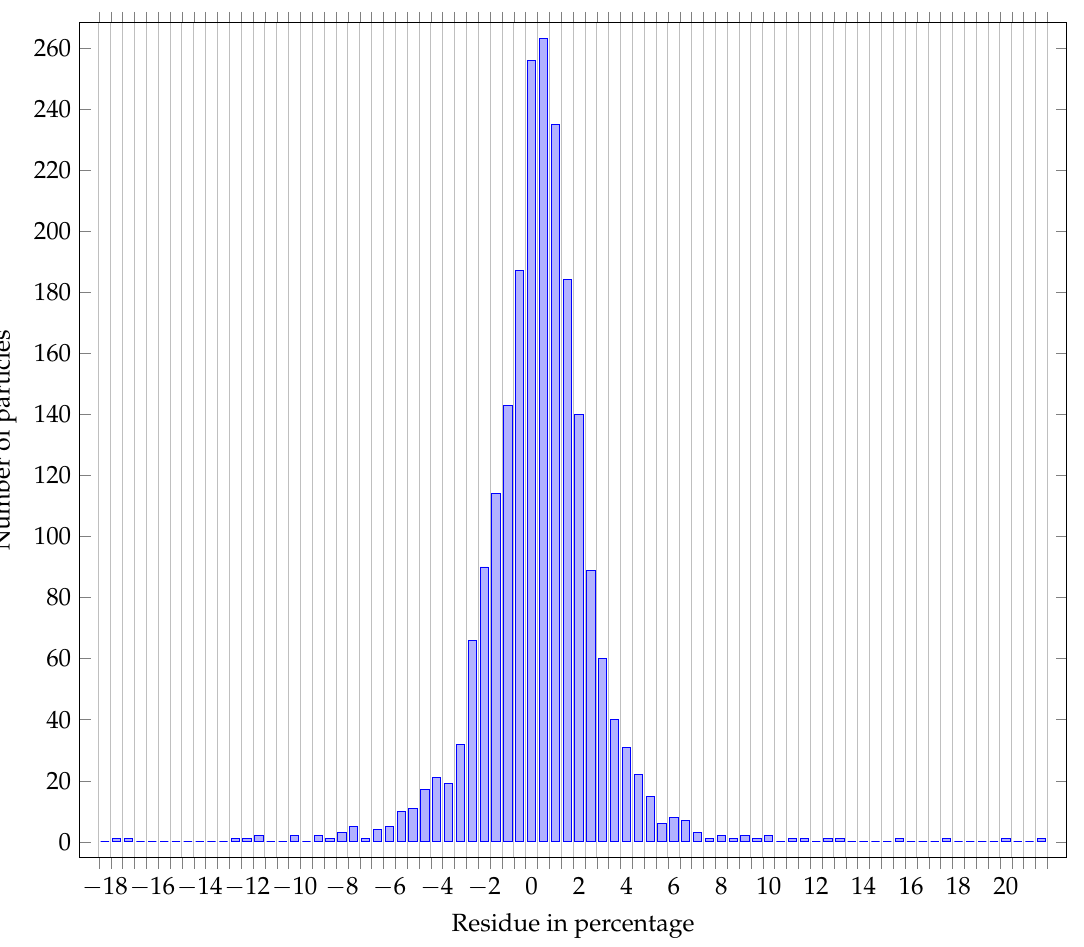
Figure 13. Residue distribution of equivalent surface diameter (in